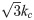
Comparison of analytically and numerically obtained solutions of the Moiré interference model.
A Top: unfiltered Moiré interference patterns. Black line separates analytical (left, see Eq (52)) from numerical result (right). Bottom: amplitude spectrum of numerically obtained Moiré interference patterns. Red circle marks k
c (cf. Eq (6)), blue circle indicates 3kc. Note the high frequency contributions, indicated by the small yellow circles. B Top: Numerically obtained Moiré interference pattern after thresholding for cells with OSI > 0.25 (left, see Methods for the OSI definition used) and subsequent smoothing (right, see text). Inset shows a magnified region of the OSI-filtered domain layout together with the RGC mosaic from which the neurons sample. Bottom: amplitude spectrum of the numerically obtained thresholded and smoothed layout. Red circle indicates k
c (cf. Eq (6)). C Orientation domain layout (top) and amplitude spectrum (bottom) obtained by calculating the lowest spatial frequency contributions of the layout in A (Eq (8)). All model parameters as in Fig 3.